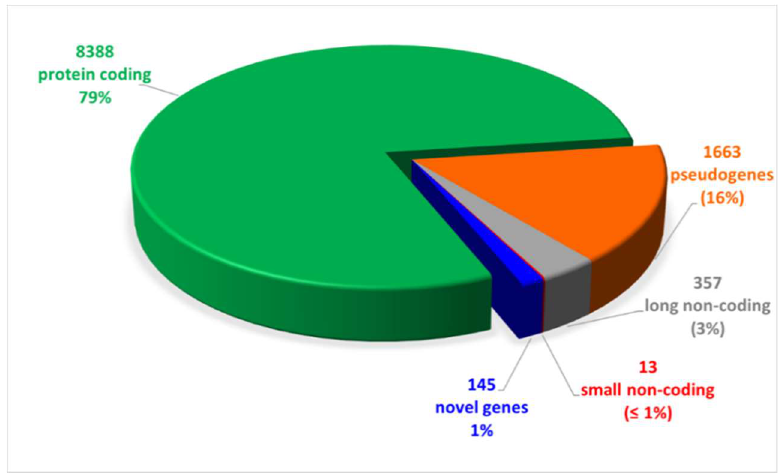
Figure 2. Pie chart of expressed genes, grouped by biotypes provided by the ensemble annotation. Out of 10,566 expressed genes, 79% (8388) was represented by protein coding genes. The remain- ing 21% was constituted by non-coding RNAs (16% pseudogenes, 3% and 1% long and small non- coding, respectively, and 1% novel